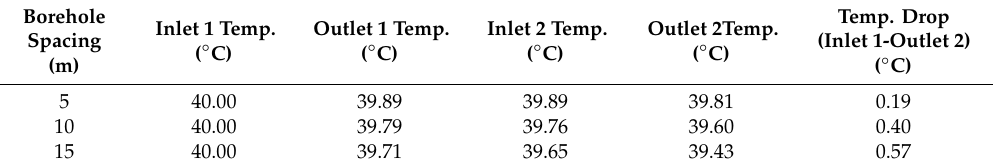
Table 5. Simulation results for three di ff erent borehole separation